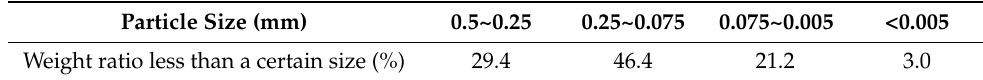
Table 1. Sediment particle gradation table.